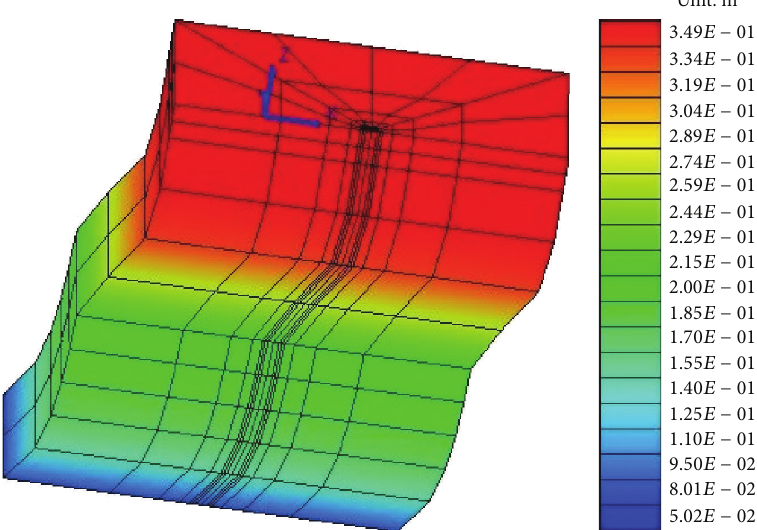
Figure 7: Deformed mesh at the end of the motion, scale 1:10.